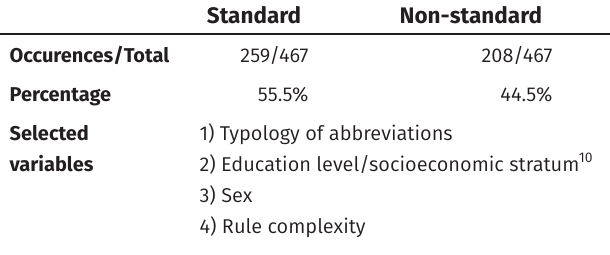
Table 1: Round data in the Goldvarb X